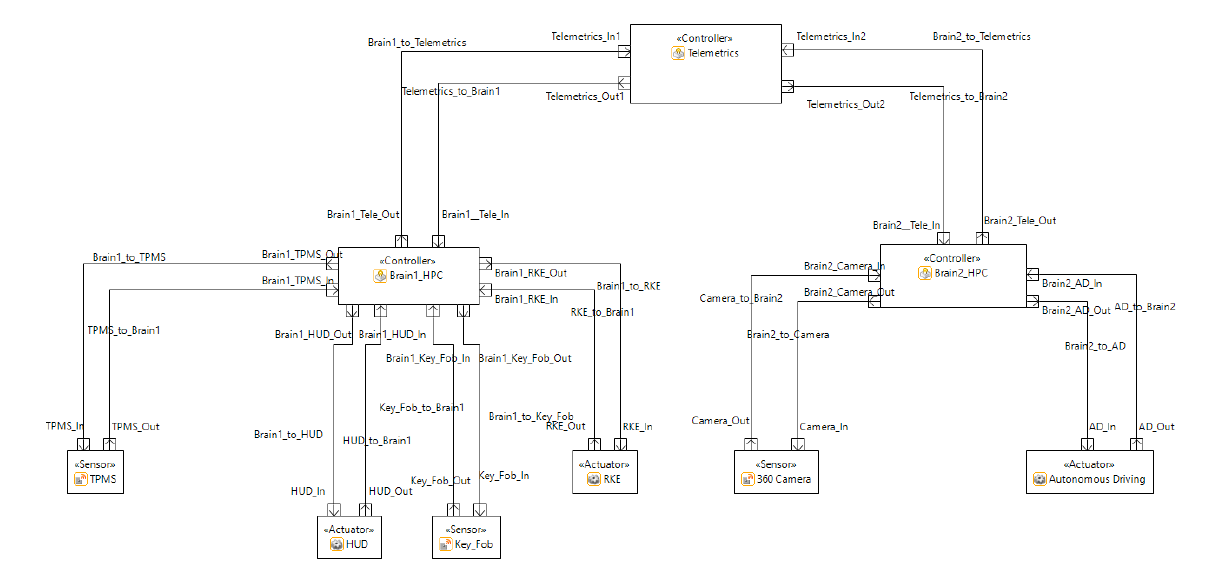
Figure 15. Realization of Two-Brain Architecture in Ansys Medini